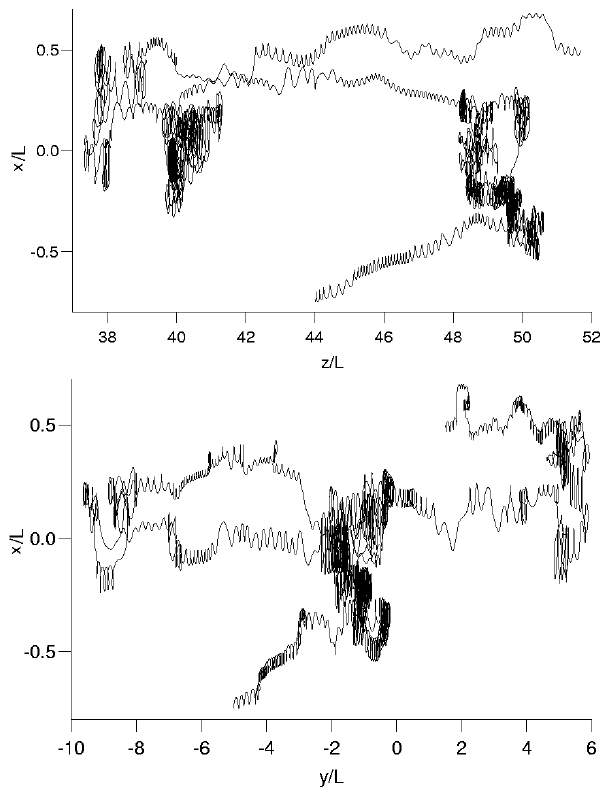
Fig. 3. A sample of a penetrating ion trajectory in the simulation box.